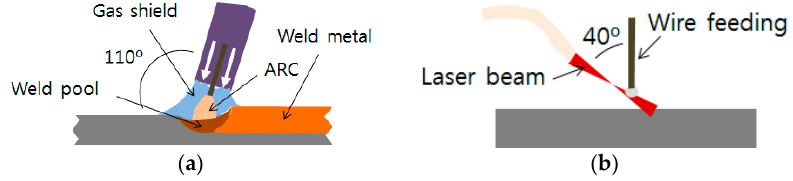
Figure 1. Setup for experiments: ( a ) Gas metal arc welding; ( b ) Laser melting.